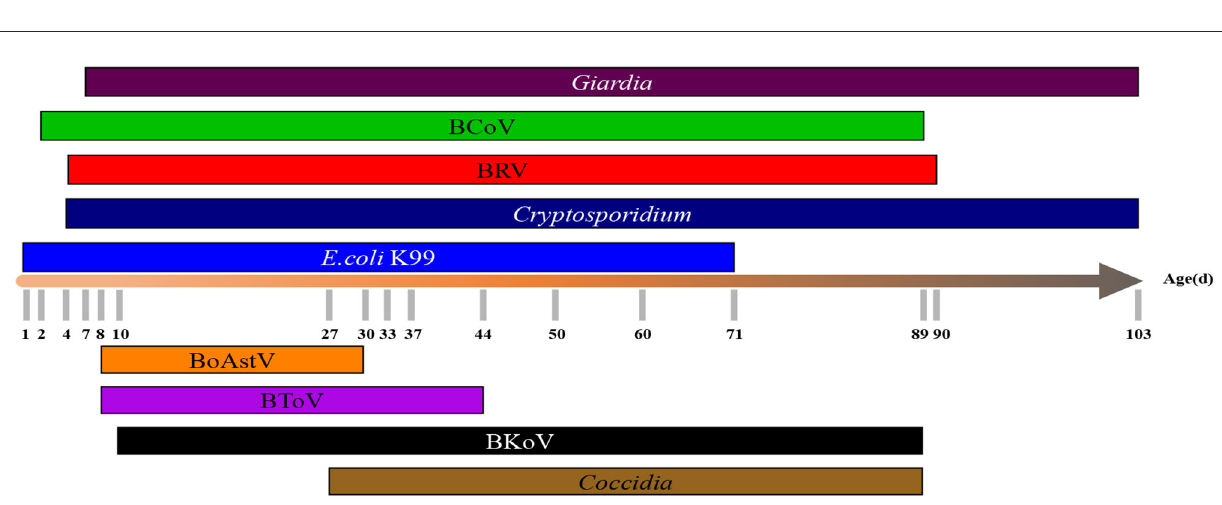
Therefore, it is important to take care of deworming cattle in all growth stages and pay attention to biological safety